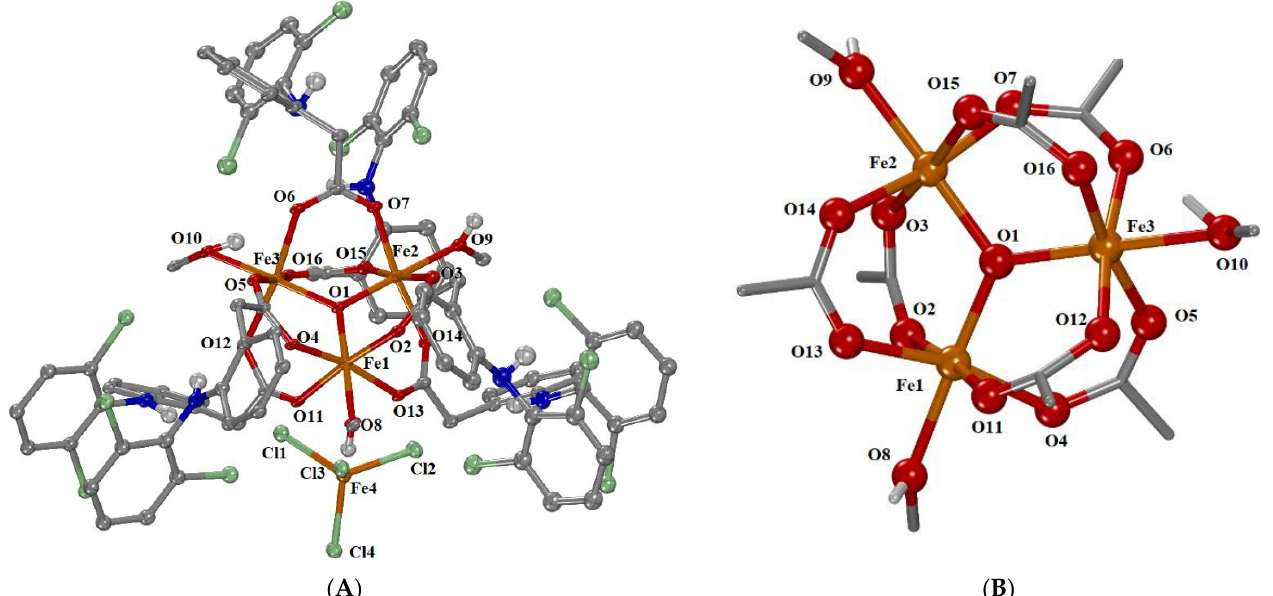
Figure 4. ( A ) The molecular structure of complex [Fe 3 O(μ 2 -dicl-O, O′ ) 6 (ΜeΟΗ) 3 ][FeCl 4 ]. Aromatic and methyl hydrogen atoms as well as diclofenac acid and methanol and water solvate molecules are omitted for clarity. ( B ) The core structure of the cationic complex [Fe 3 O(μ 2 -dicl-O, O′ ) 6 (MeOH) 3 ] + . (Atom color code: C in grey; H in white; O in red; N in blue; Fe in orange; Cl in light green).